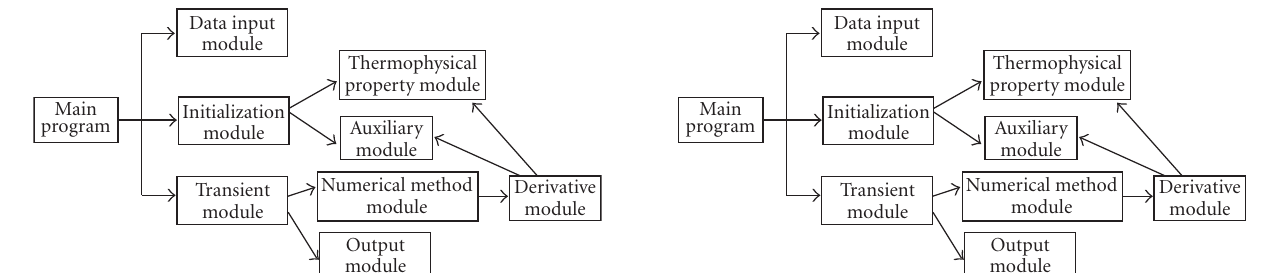
Figure 3: Calling relationships of the modules. Figure 4: N-S flowchart of the